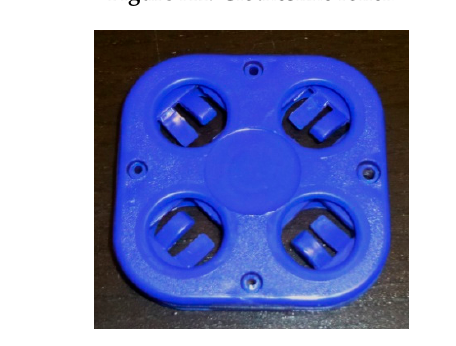
Figure A2. Coin holder.